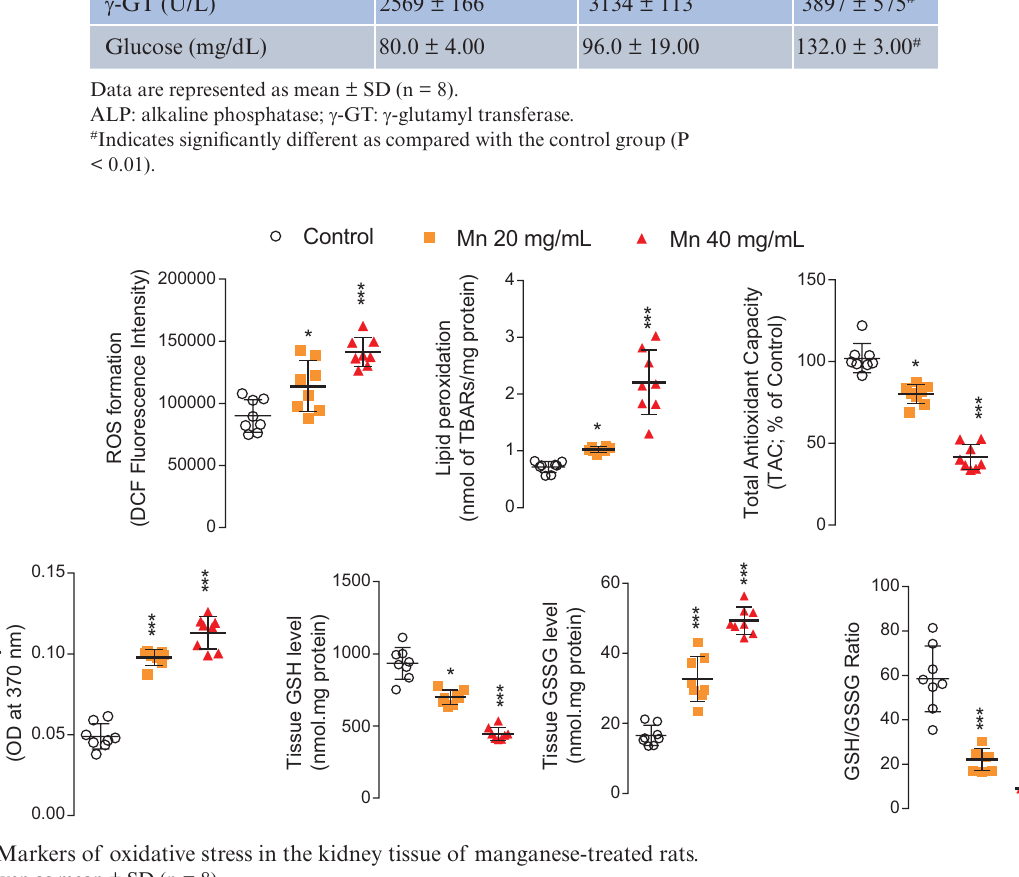
(Figure 3). Moreover, a significant increment of mitochon- drial depolarization and swelling was detected in the kid- ney mitochondria of Mn-treated animals (Figure 3). Lipid peroxidation was also dose-dependently increased in the kidney mitochondria isolated from Mn-exposed animals (Figure 3). Significant interstitial inflammation and tubular atrophy were evident in the kidneys of Mn 20 and 40 mg/mL groups (Figure 4 and Table 3). Moreover, Mn 40 mg/mL caused renal tissue necrosis (Figure 4 and Table